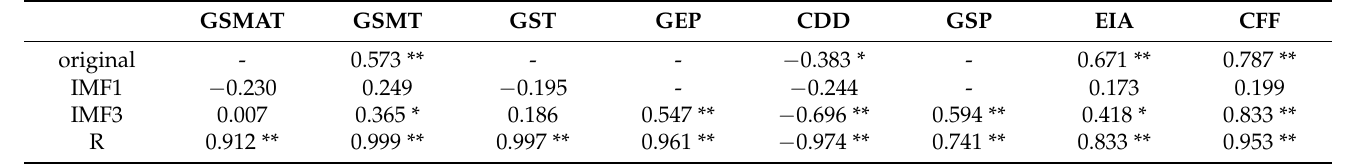
Table 4. Relationship between maize yield and climatic factors and human activities at different